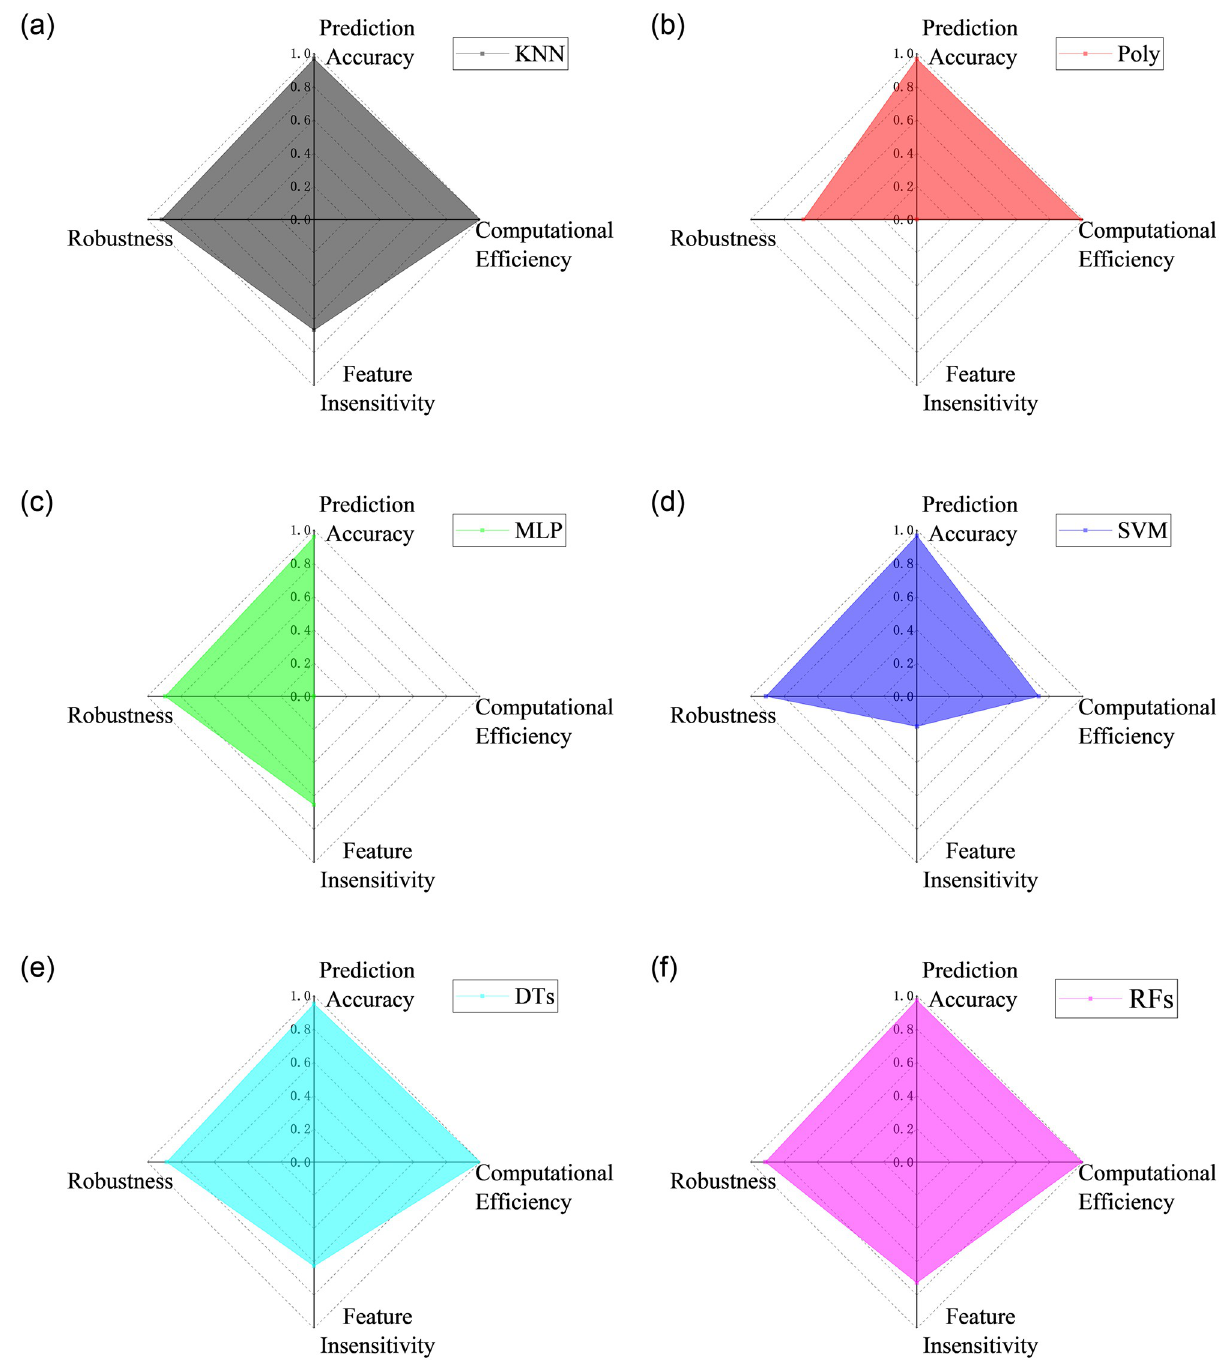
Fig 30. Comprehensive evaluation on the six machine learning